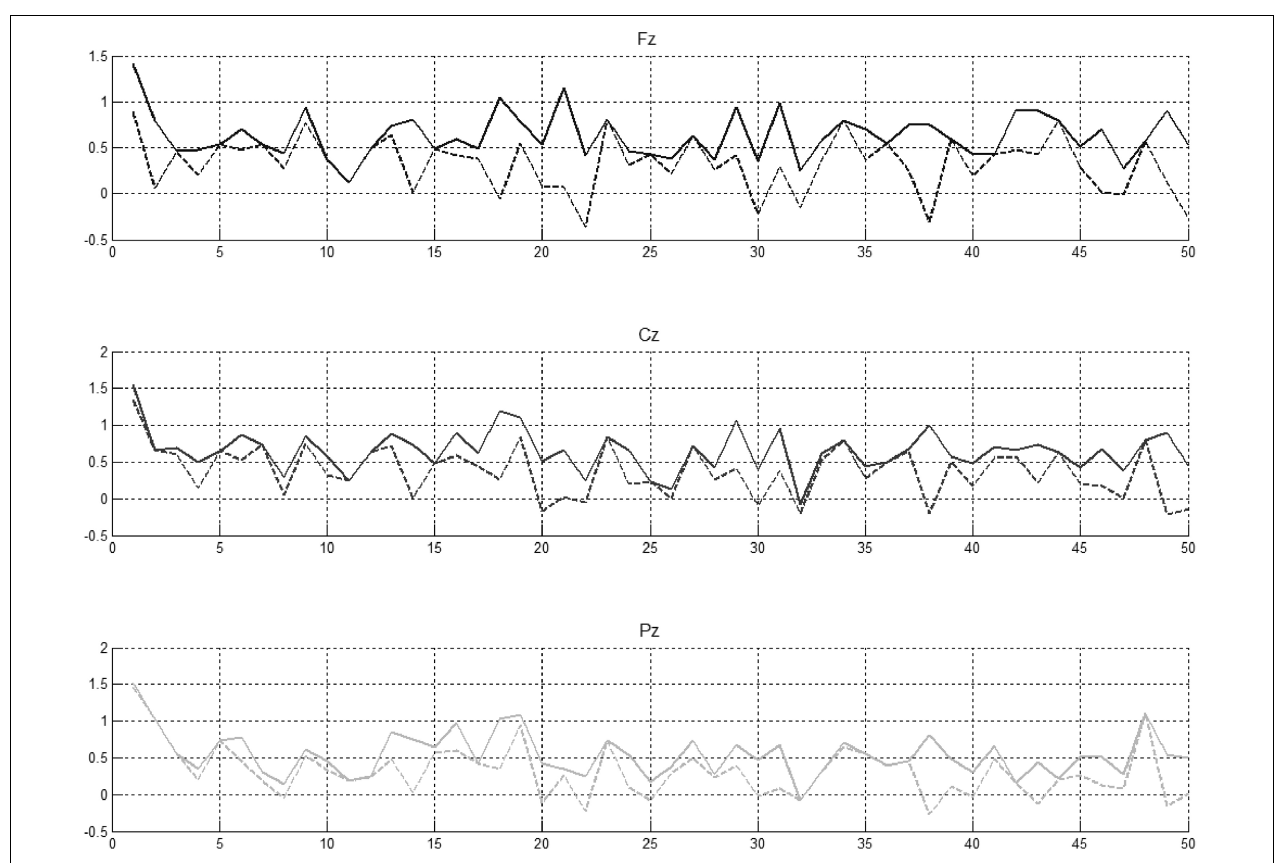
FIGURE 6 | Preceding novel stimuli (NG) vs. amplitude of the P300 peak in Fz, Cz, and Pz. P300 peak amplitudes between 250 and 450 ms (solid lines) and between 350 and 450 ms (indented lines) computed for schizophrenic